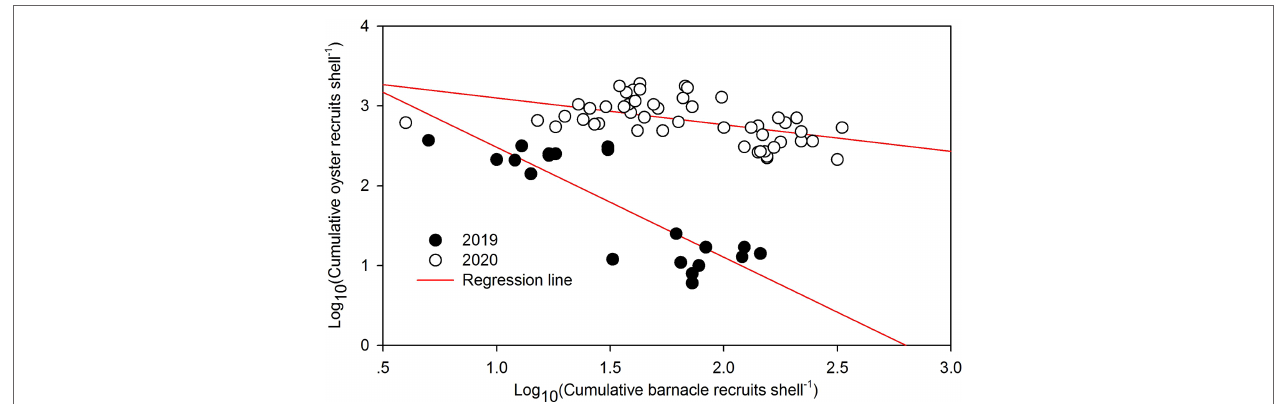
FIGURE 7 | Correlations in cumulative recruits between the barnacle and the oysters across all the monitoring stations. Evident negative associations in the cumulative recruits were present between the oyster and the barnacle ( p <